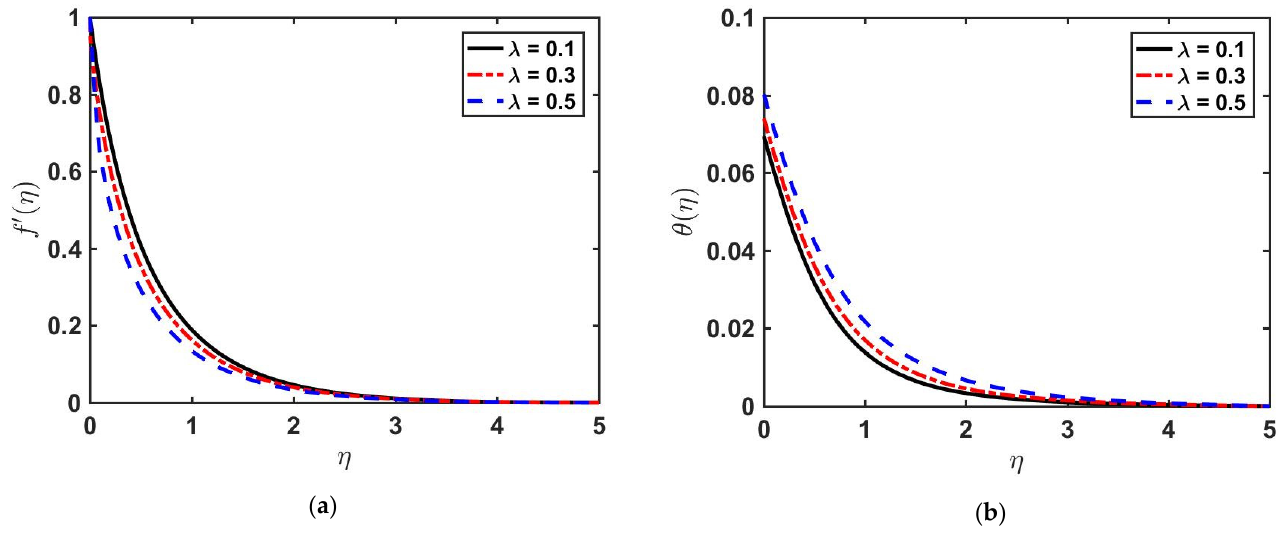
Figure 2. Effect of 𝝀 on ( a ) 𝒇′(𝜼) , ( b ) 𝜽(𝜼) .